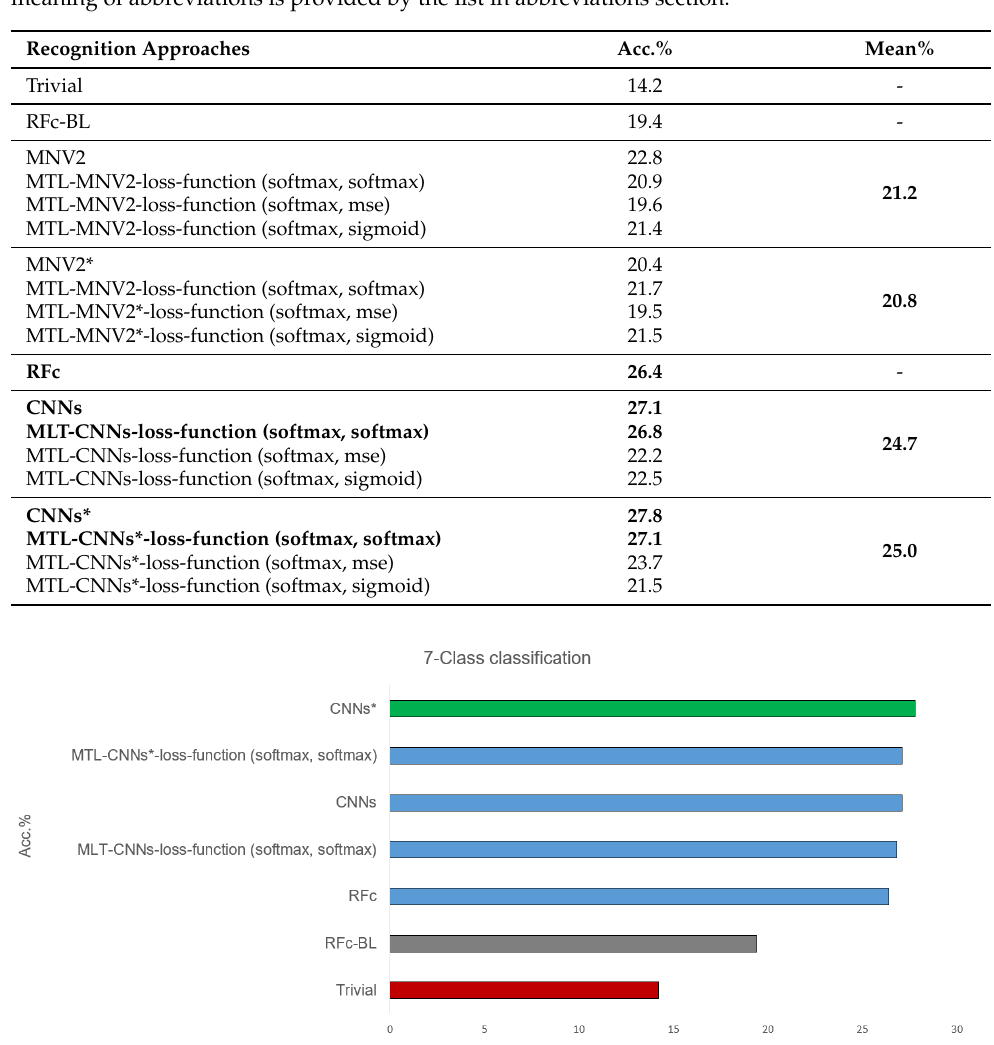
Table 2. Recognition approaches accuracy results of phasic stimuli 7-class classification task, the meaning of abbreviations is provided by the list in abbreviations section.